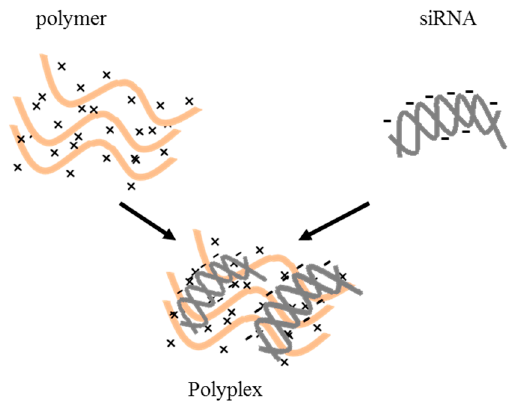
Figure 6. Polymeric delivery material developed in Reference [111]. Polymer: PGA conjugated with amine moieties.